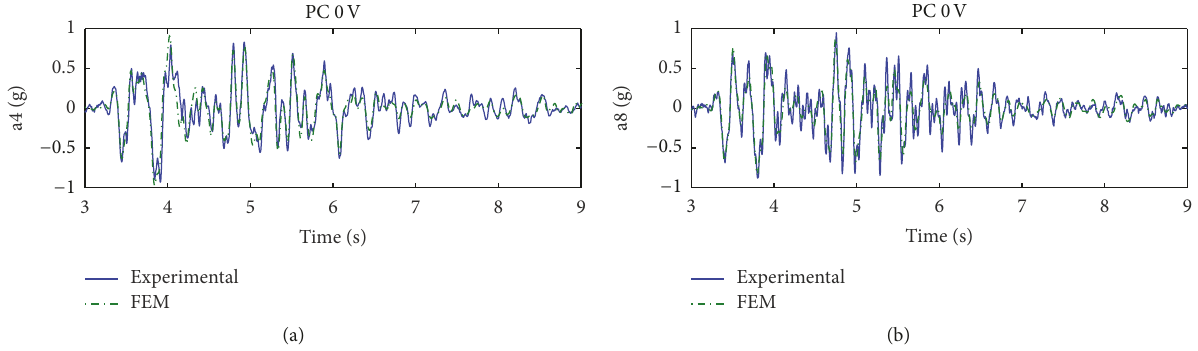
Figure 12: Passive connected configuration (PC), experimental versus FEM 4th floor structure A and 2nd floor structure B acceleration 𝑥 direction, voltage level 0V. Kobe test PGA 0.5